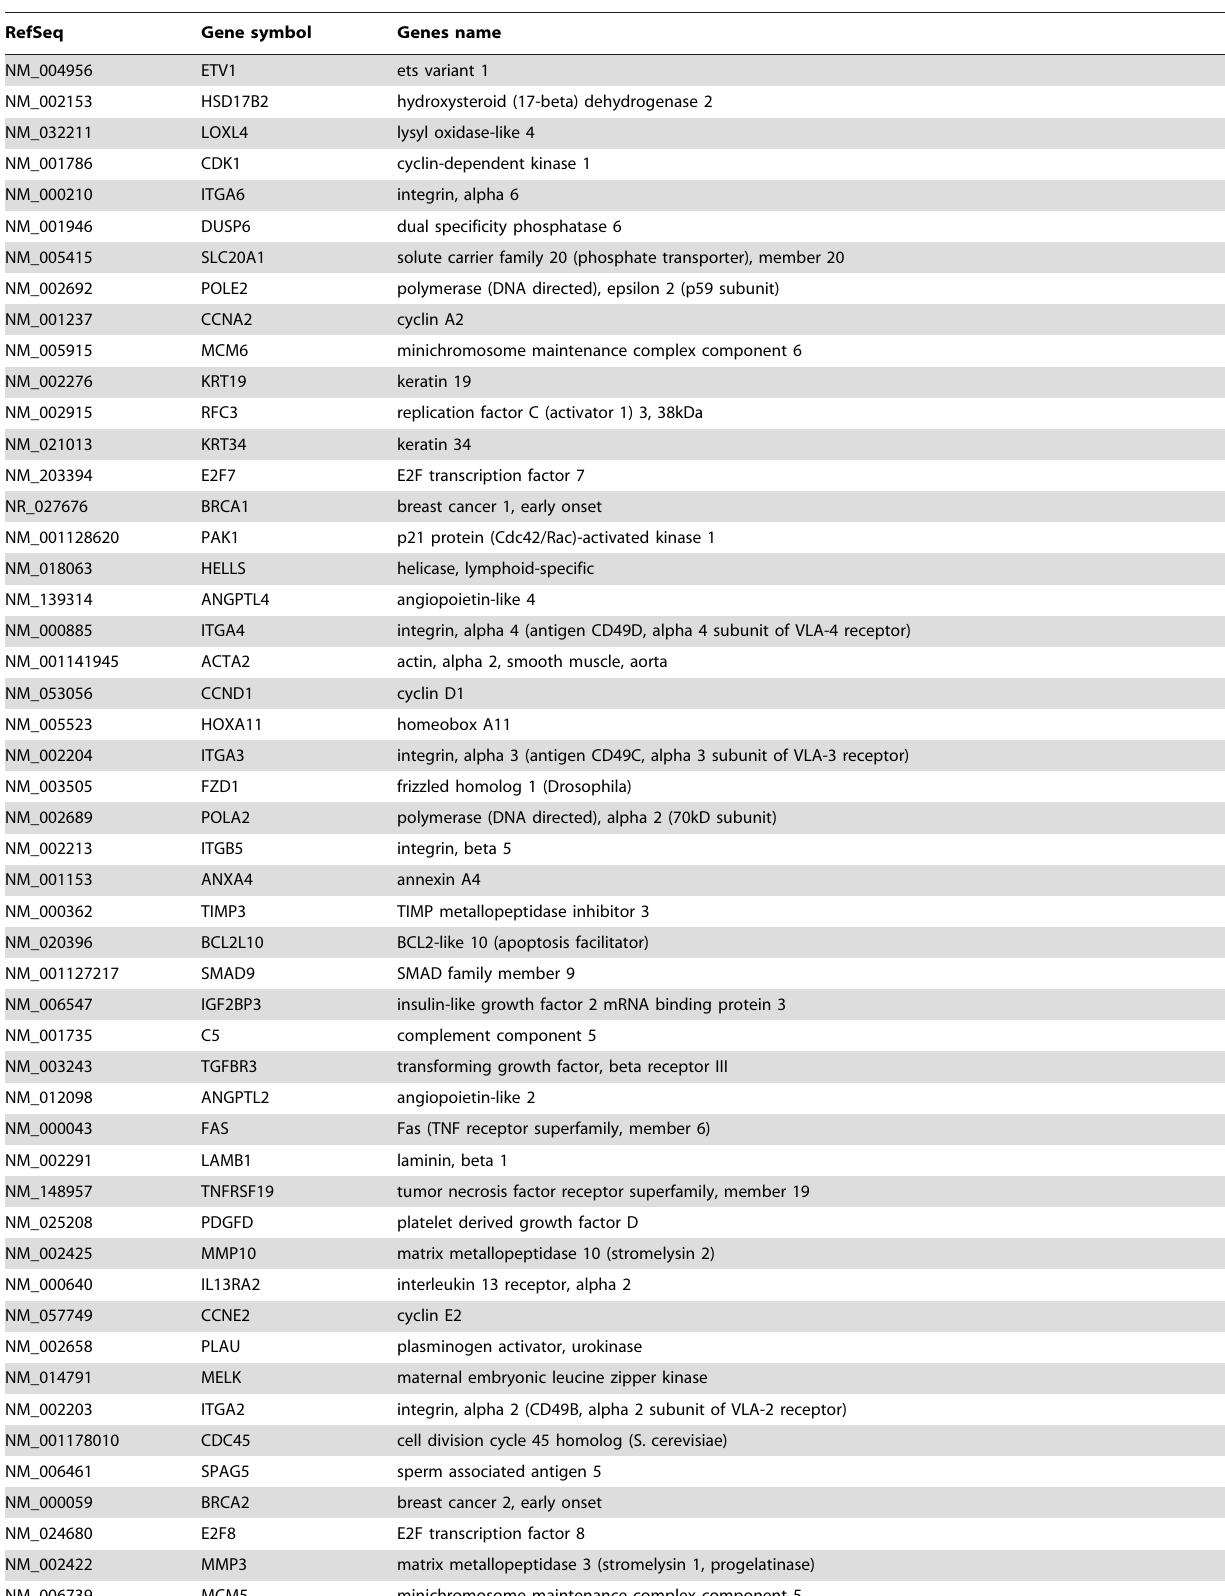
Table 5. Name of down-regulated genes.